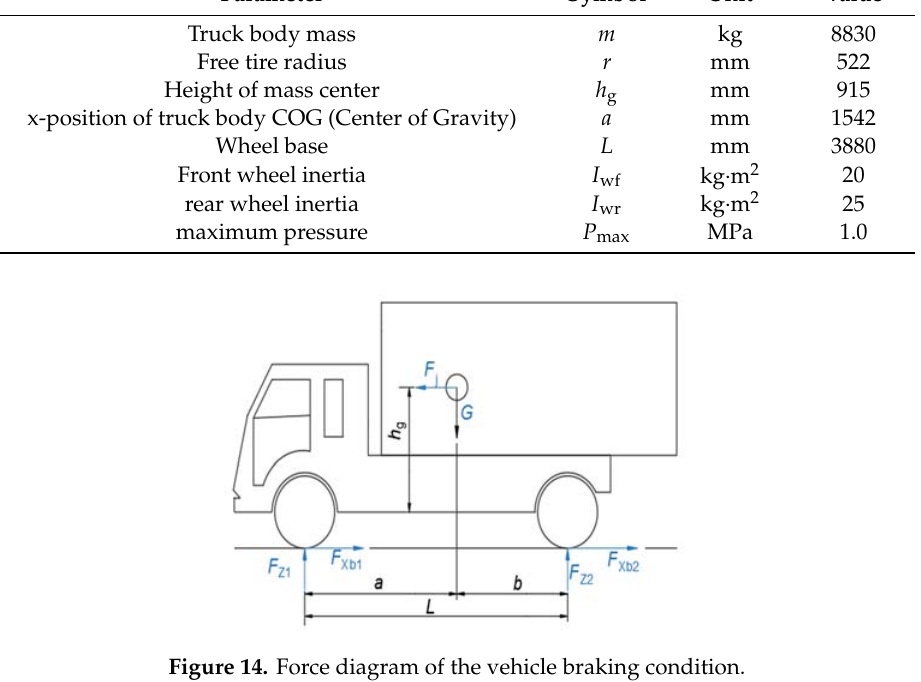
Figure 14. Force diagram of the vehicle braking condition. Table 5. Comparison of deceleration of simulation and experiment.